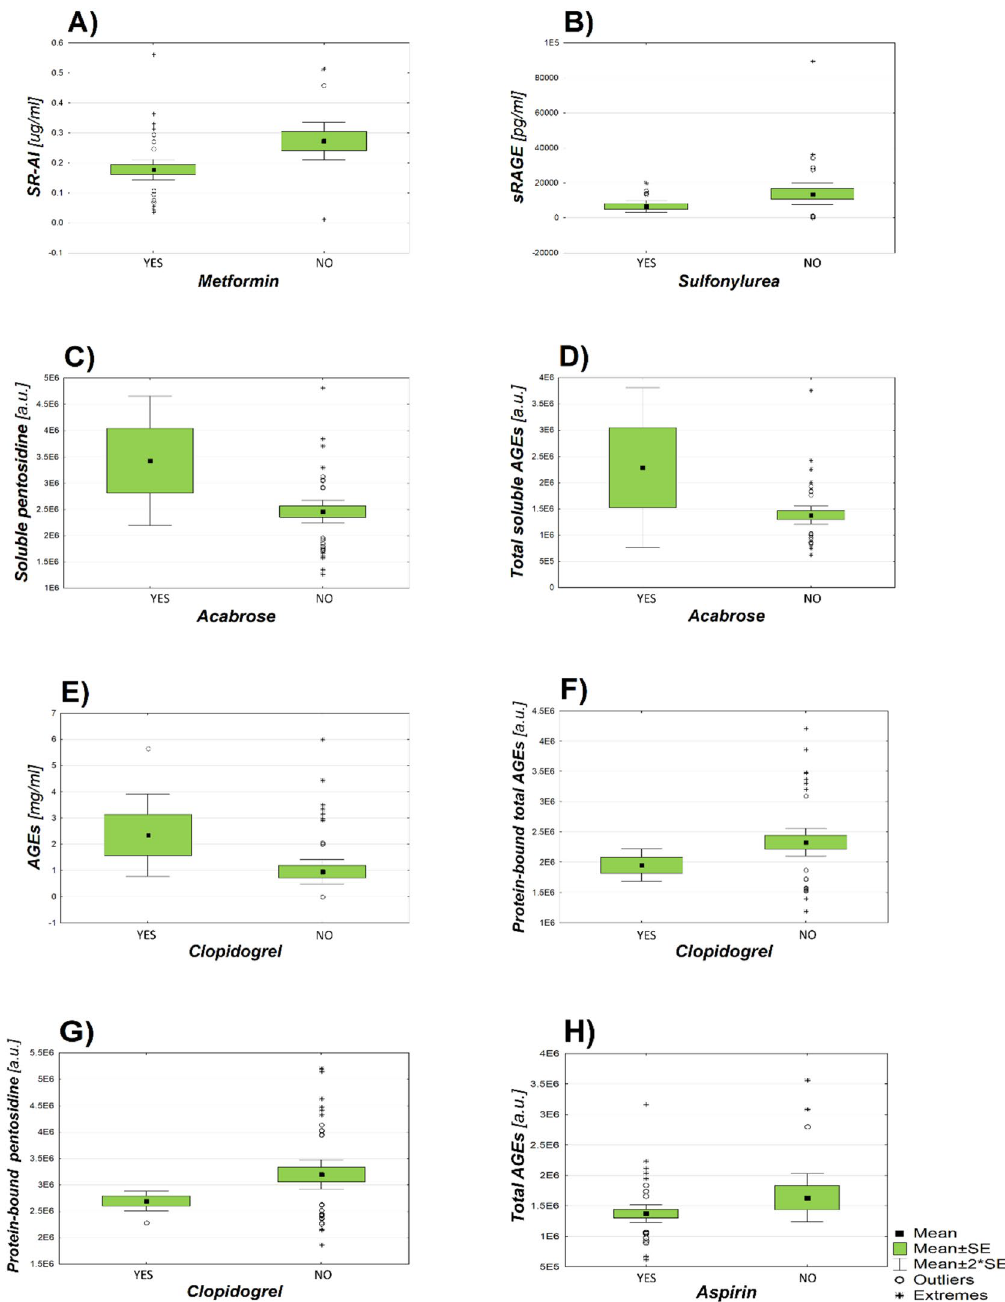
Figure 4. Graphs of dependence of the intake of AGEs inhibitors by patients and the content of AGEs and their receptors in the blood serum. The values given below are the mean of the results and the standard errors of these means (Mean ± SE). ( A ) The dependence of the concentration of SR-AI receptors in the blood serum of patients on the intake of metformin; (number of subjects = 54; YES (0.1773 ± 0.017 µg/ml), NO (0.273 ± 0.032 µg/ml)). ( B ) Dependence of the concentration of sRAGE receptors on the intake of sulphnylurea; (n = 49; YES (6577 ± 1699 pg/ml), NO (13,669 ± 3052 pg/ml)). ( C ) Dependence of soluble pentosidine fluorescence on the intake of acabrosis; (n = 46; YES (2,749,066 ± 232,013 a.u.), NO (3,167,709 ± 132,824 a.u.)). ( D ) Dependence of total soluble AGEs fluorescence on acarbose intake; (n = 47; YES (2,285,230 ± 762,302 a.u.), NO (1,383,013 ± 86,164 a.u.)). ( E ) Dependence of AGEs concentration on the intake of clopidogrel; (n = 48; YES ( 2.351 ± 0.783 mg/ml), NO (0.9579 ± 0.233 mg/ml)). ( F ) Dependence of fluorescence of protein-bound low- molecular AGEs on clopidogrel intake; (n = 47; YES (2,694,944 ± 94,577 a.u.), NO (3,198,113 ± 139,294 a.u.)). ( G ) Dependence of total protein-bound AGEs fluorescence on clopidogrel intake; (n = 47; YES (1,950,442 ± 132,149 a.u.), NO (2,326,301 ± 113,815 a.u.)). ( H ) Dependence of total AGEs fluorescence on aspirin intake; (n = 58; YES (1,372,031 ± 71,806 a.u.), NO (1,633,724 ± 199,279